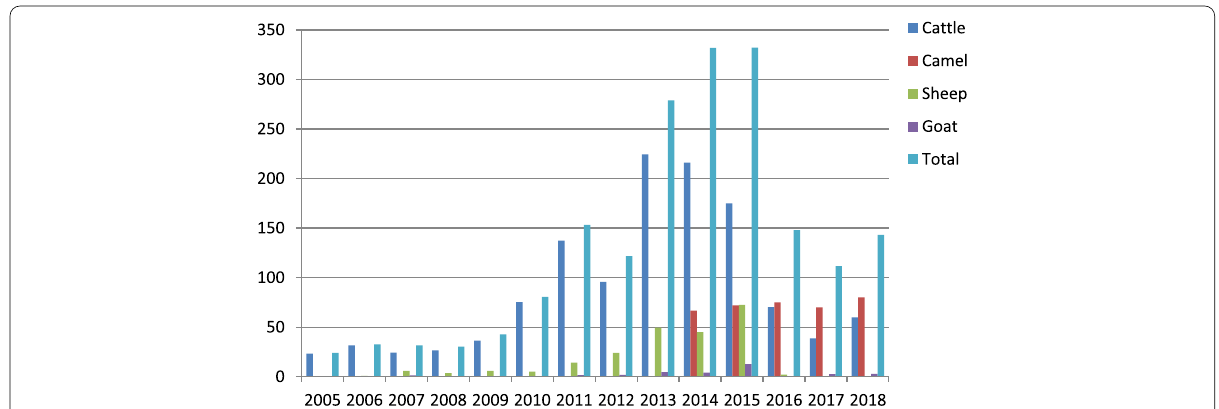
Fig. 3 Data of export value of Ethiopian livestock (in millions USD) by FAO. Source: author computation from FAO